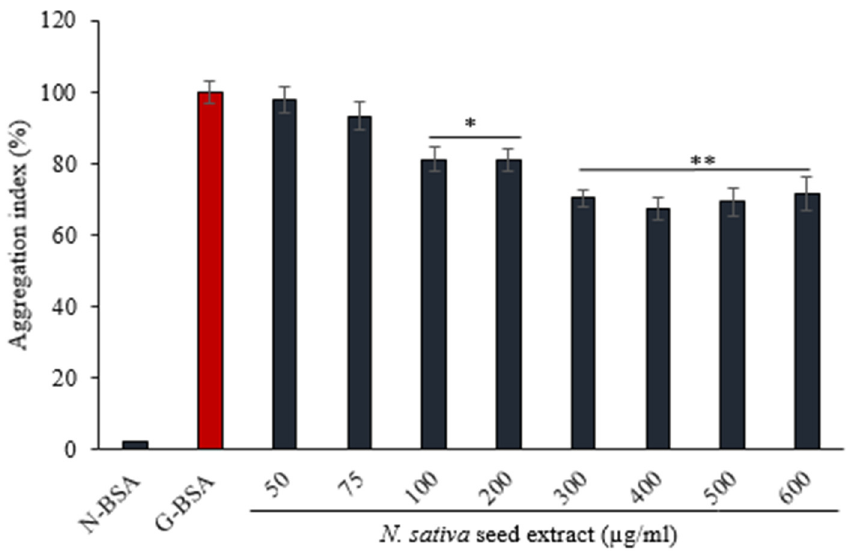
Figure 6. Effect of N. sativa seed extract on aggregation index. N-BSA: Native BSA incubated alone for 15 days. G-BSA: BSA incubated with glucose for 15 days and considered as negative control. The results are presented as means ± SEM ( n = 3). The statistical analysis was performed by using ANOVA (* p ≤ 0.05, ** p ≤ 0.01).